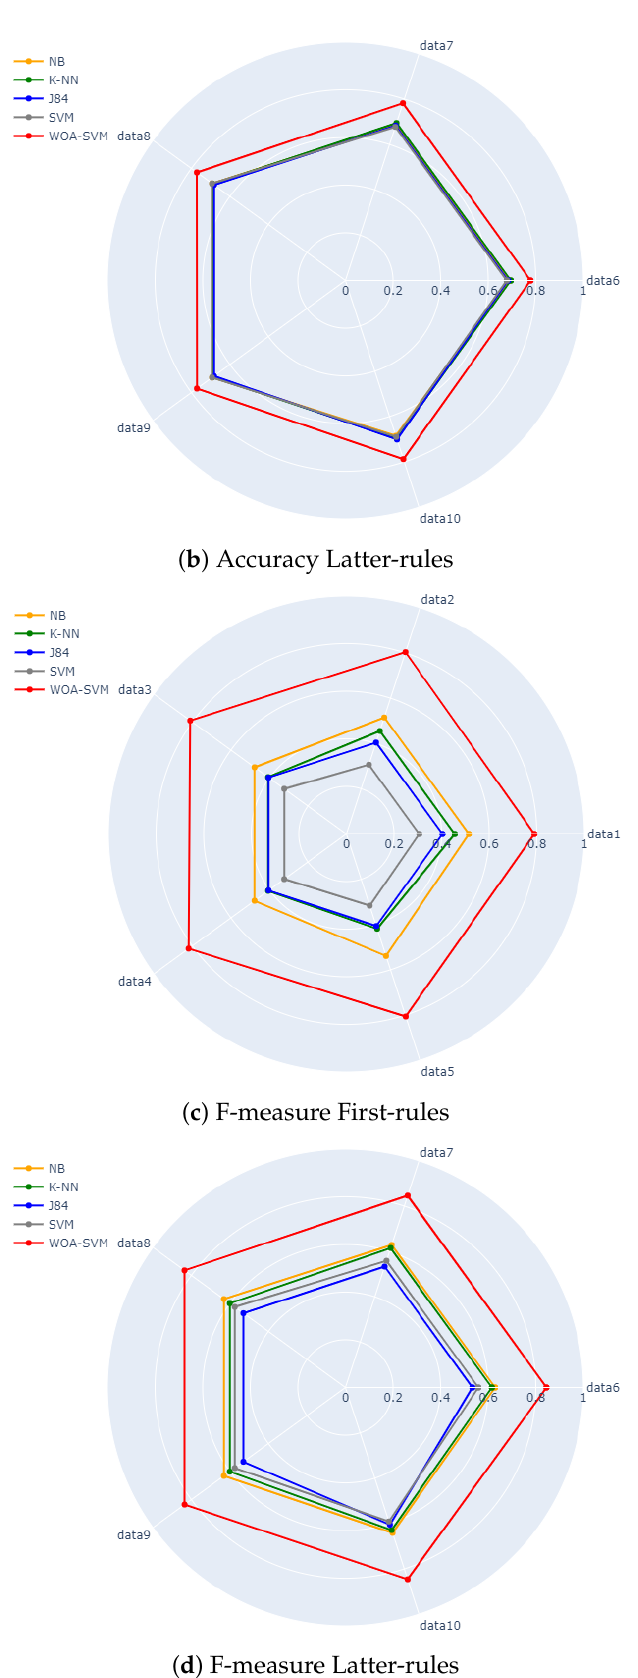
Figure 4. Radar chart for comparing standard classification algorithms in terms of accuracy and